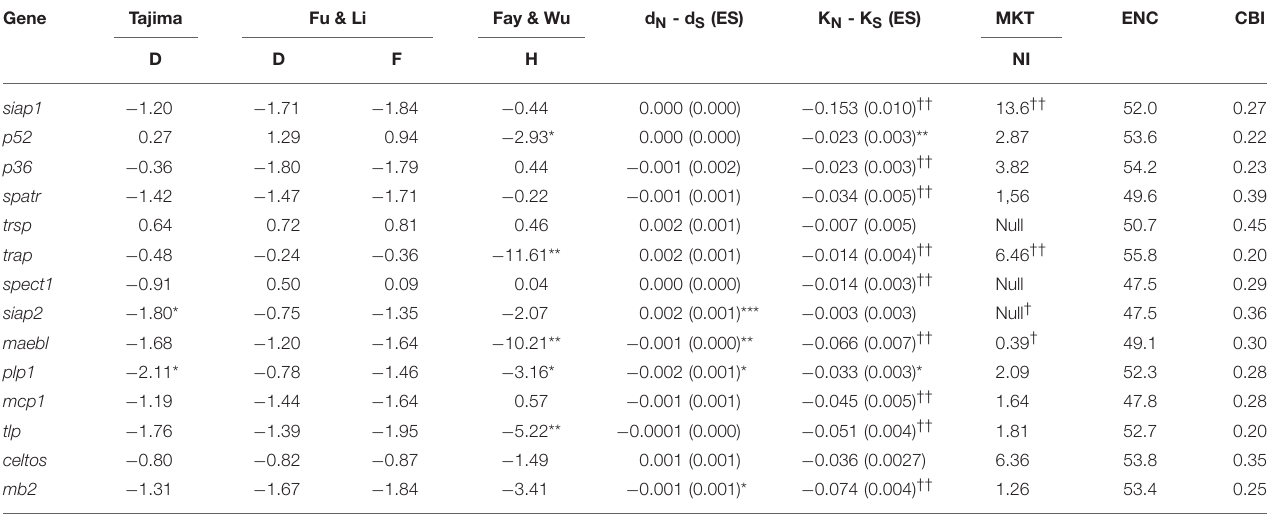
TABLE 3 | Neutrality and codon usage bias